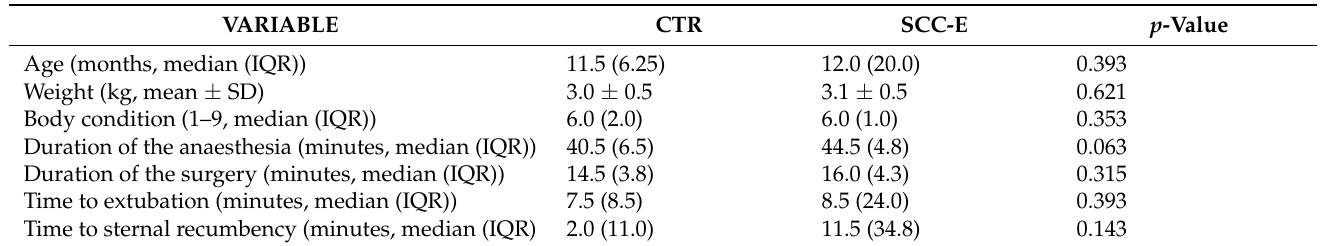
Table 1. Demographic data, duration of anaesthesia time, duration of surgery, times until extubation and until sternal recumbency in cats undergoing ovariohysterectomy with (SCC-E group) or without (CTR group) sacrococcygeal epidural ( n = 10 in each